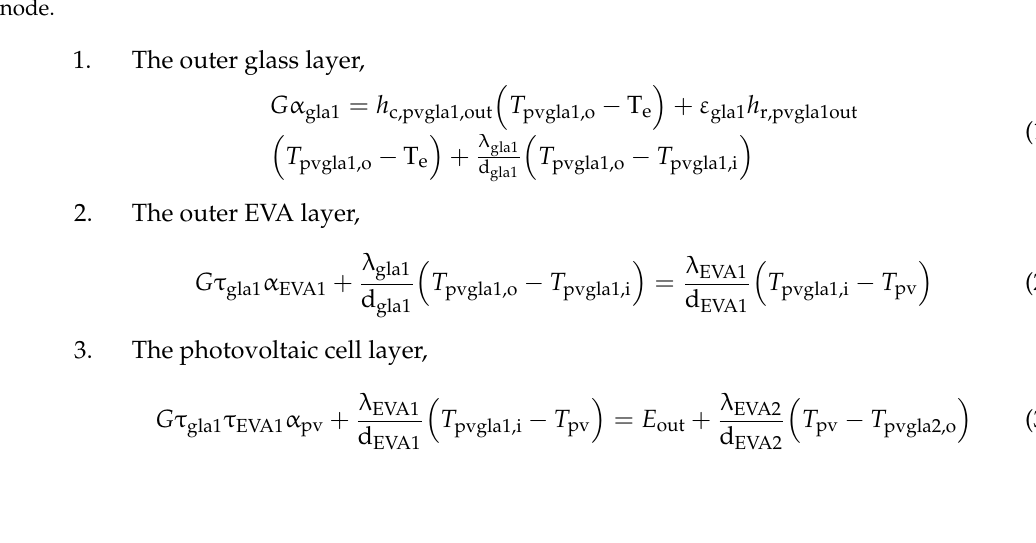
Figure 1. Schematic diagram of ST-PVW structure: ( a ) Layered diagram of ST-PVW structure; ( b ) The name of each part; ( c ) The temperature node.